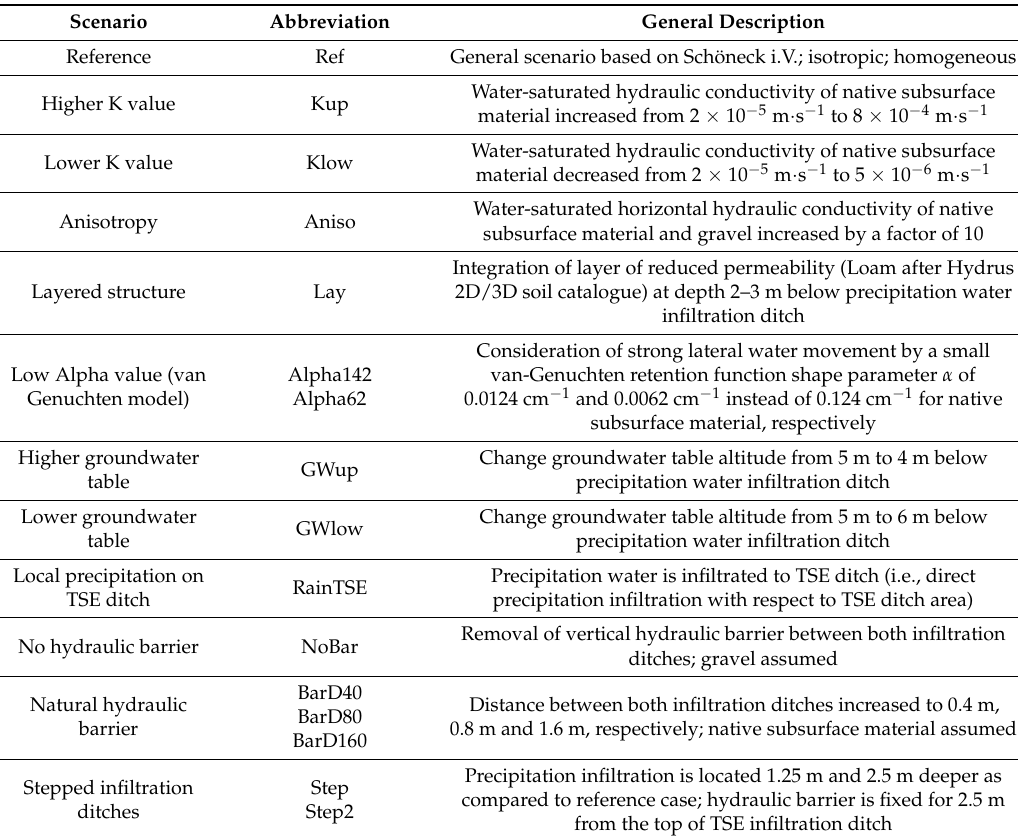
Table 4. Investigated scenarios: For every scenario except “Local precipitation on TSE ditch”, a model with and without precipitation event was run. Due to varying travel times, the tracer-labelled period was adapted for scenarios Kup and Klow to create best comparability at locations of observation nodes 2 and 4, and flux line 3. Please note that abbreviation Alpha142 corresponds to a van-Genuchten shape parameter α of 0.0124 cm − 1